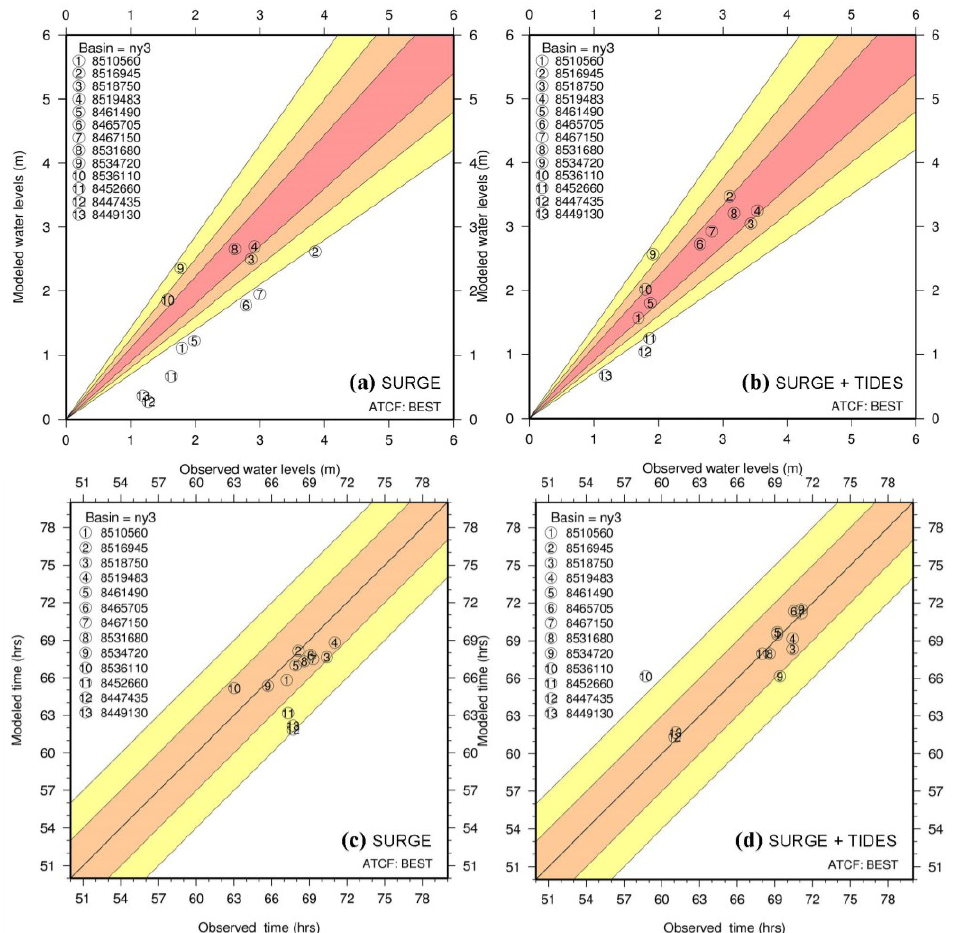
Figure 12. NOAA stations vs. SLOSH maximum water levels for ( a ) surge and ( b ) surge-plus-tides and the time-of-arrival of the peak water levels for ( c ) surge and ( d ) surge-plus-tides. In ( a ) and ( b ), the dark orange cone depicts 10% error, the orange cone depicts 20% error and the yellow cone depicts 30% error. In panel ( a ) the simulated surge at 3 NJ and at 2 NY station locations show errors between 10% and 20%, while at station locations far from the point of landfall the modeled maximum surge is underestimated. In panel ( b ) the simulated surge-plus-tides water surface elevation errors at most station locations are within the 10%–20% range. In panels ( c ) and ( d ) the stations that fall in the ±3 h error range for the time-of-arrival of the peak are within the orange band and the ±6 h error range are within the yellow band. The simulated peak arrival times at most sensor locations are within 3 h of that which was observed, except at stations in RI and MA far from the landfall location in panel ( c ), and at Cape May (8536110) in panel ( d ) which is close to the boundary of the model